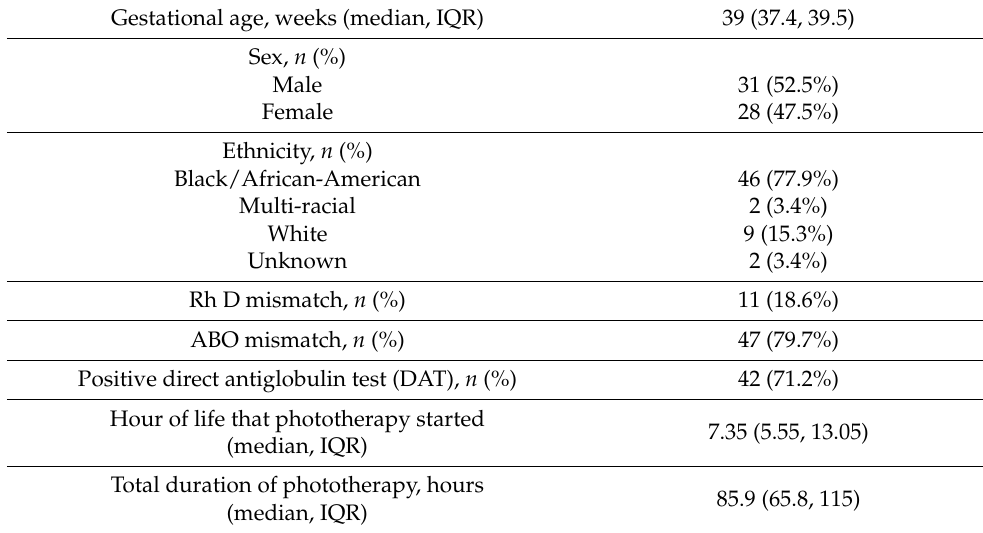
Table 2. Demographic Data and Baseline Characteristics.